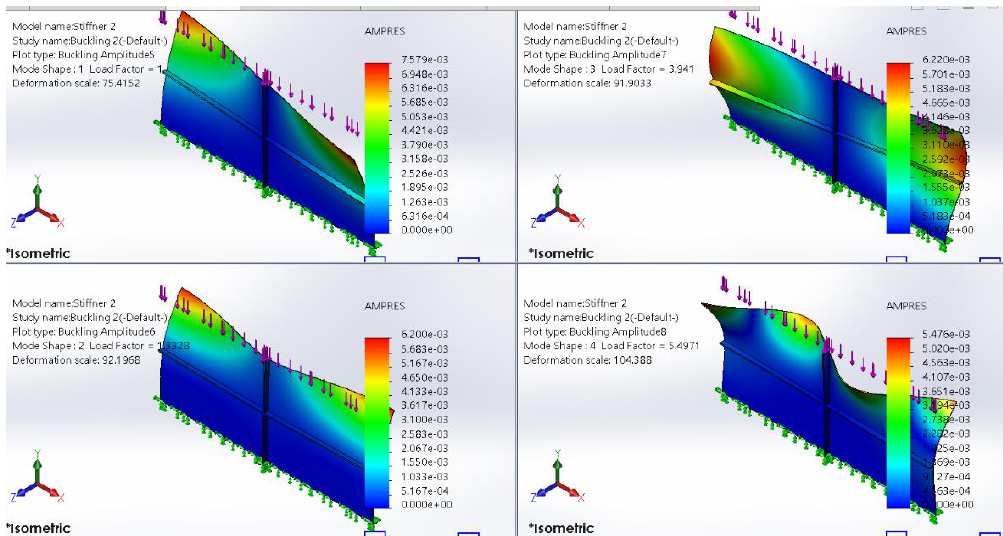
Figure 39: Buckling characteristics of the flat wall with a cross